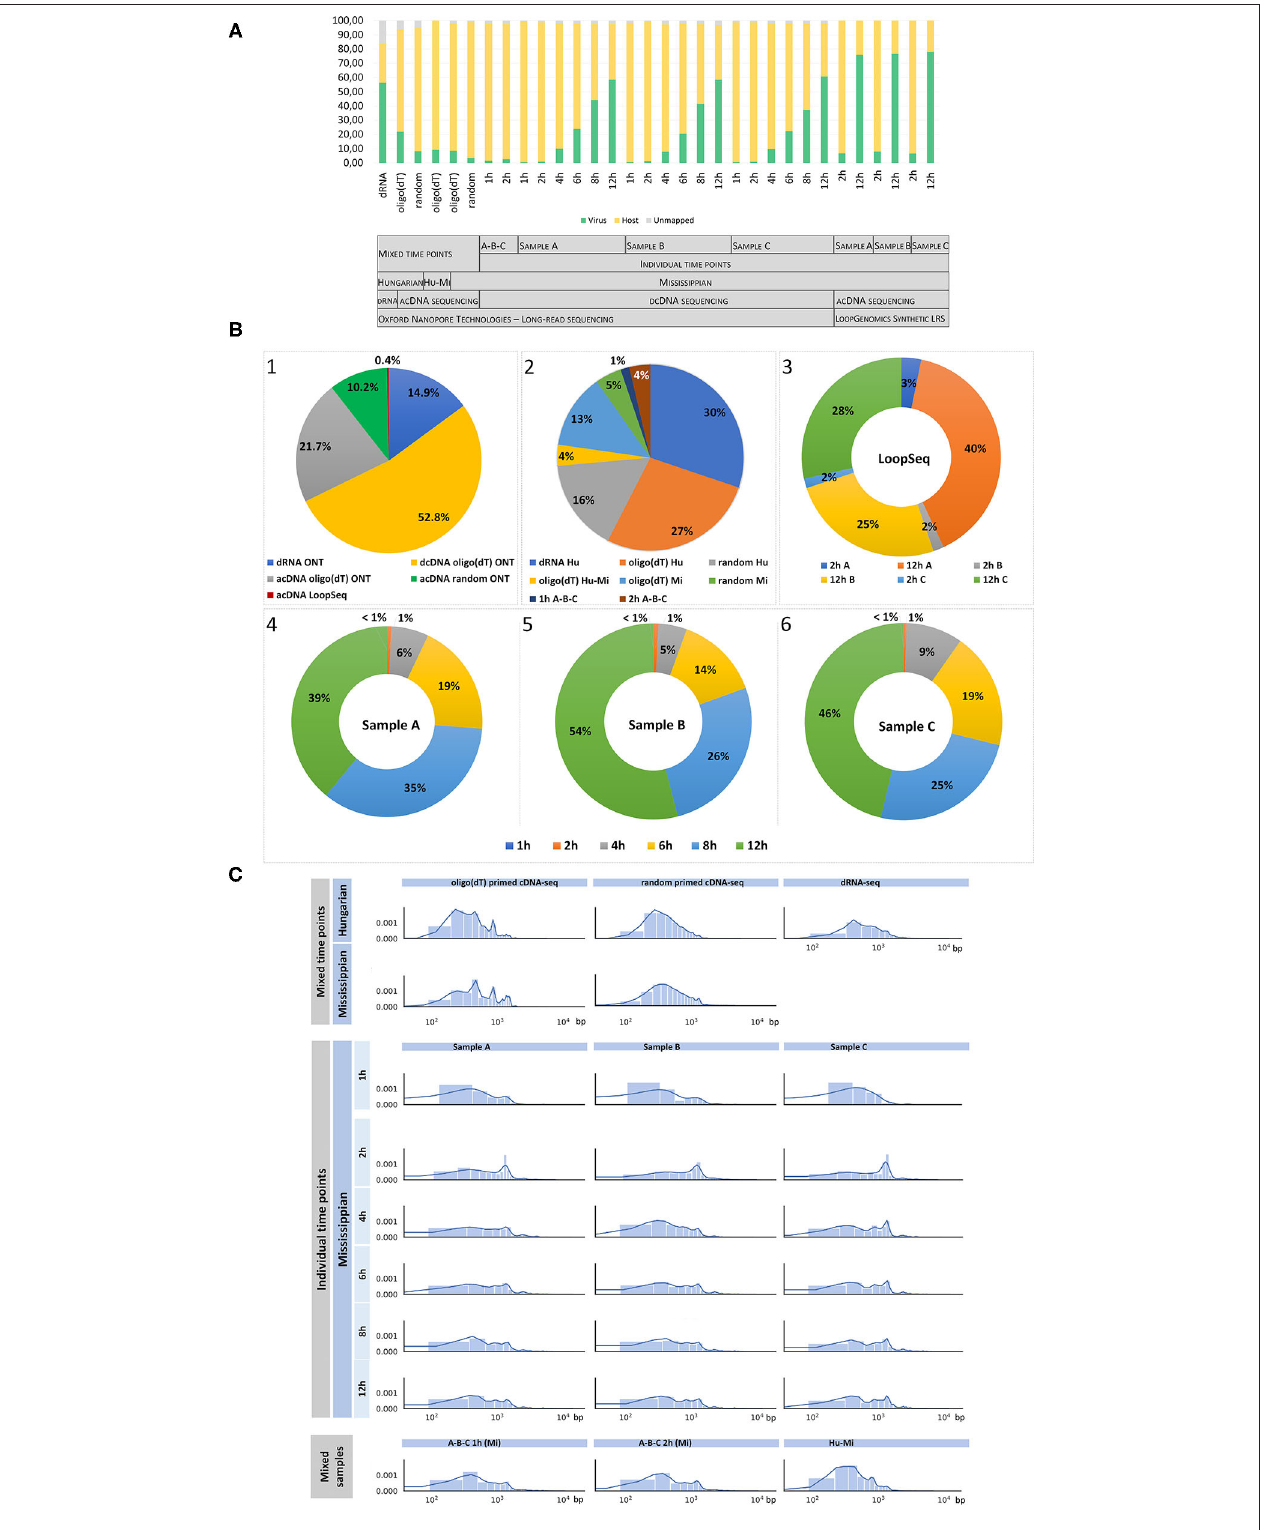
FIGURE 2 | Summary statistics of the dataset. This figure shows the statistics of sequencing reads, including the virus:host read ratios (A) , the proportion between the total viral reads (B1) generated by various sequencing techniques, and the ratios of reads obtained from non-time-varying (“static”) samples (B2) and